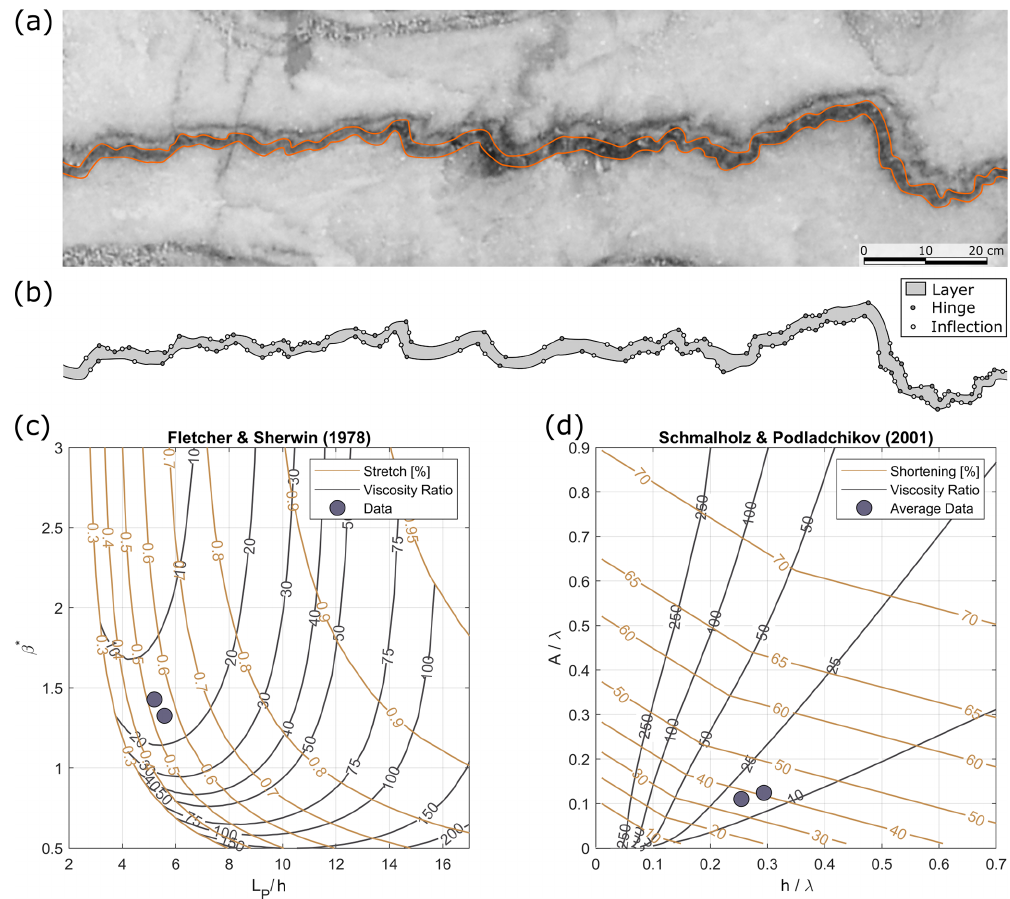
Figure 9. Fold shape analysis using FGT. (a) Small-scale fold structure (Fig. 8a). (b) Position of inflection points and hinges. (c) Estimates of layer-parallel shortening stretch and viscosity ratio after Fletcher and Sherwin (1978). (d) Estimates of shortening and viscosity ratio after Schmalholz and Podladchikov